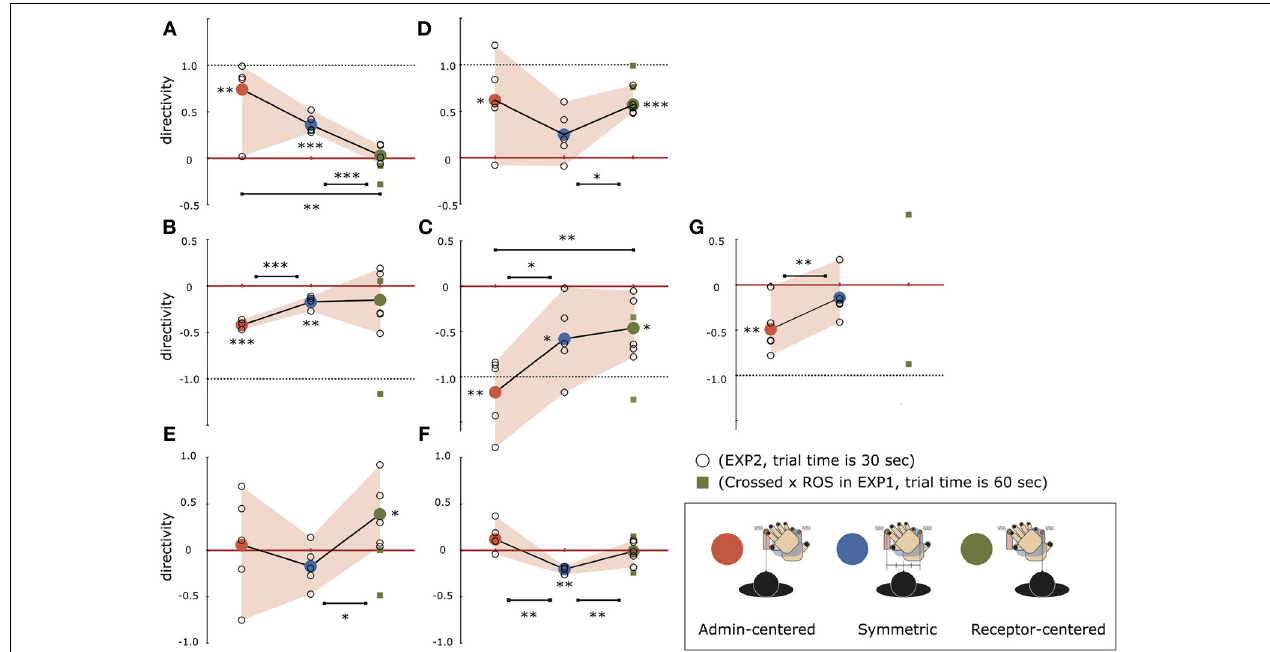
participant) are depicted together with those in Experiment II by a small square, in the region of the Receptor-centered condition. Data of participant G in the Receptor-centered condition of the Experiment II was excluded because of low attractivity. Asterisks indicate that there is significant difference of directivity between two body midline alignments or that a series of attractivity in each body midline alignment are significantly different from zero (with one-tailed Welch’s t -test, ∗ p < 0 . 05, ∗∗ p < 0 . 01, ∗∗∗ p < 0 .